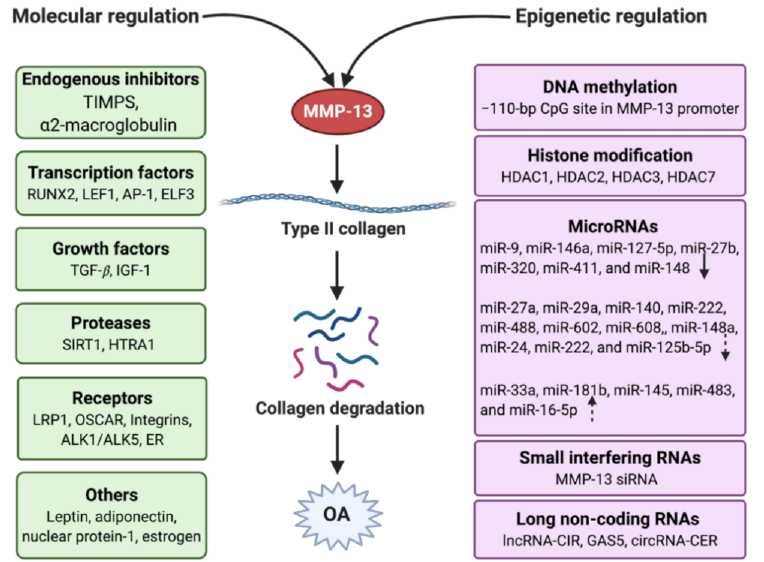
Figure 3. Regulation of MMP-13 in OA with the molecular and epigenetic mechanism. Molecular regulation involves endogenous inhibitors, transcription factors, growth factors, proteases, receptors, and other mediators. Epigenetic regulation contains DNA methylation, histone modification, and non-coding RNAs, which include microRNAs, small interfering RNAs, and long non-coding RNAs. The arrows in the microRNAs frame mean the miRNAs have different types of regulation (solid down-arrow: direct downregulation, dotted down-arrow: indirect downregulation, dotted up-arrow: indirect upregulation). Created with